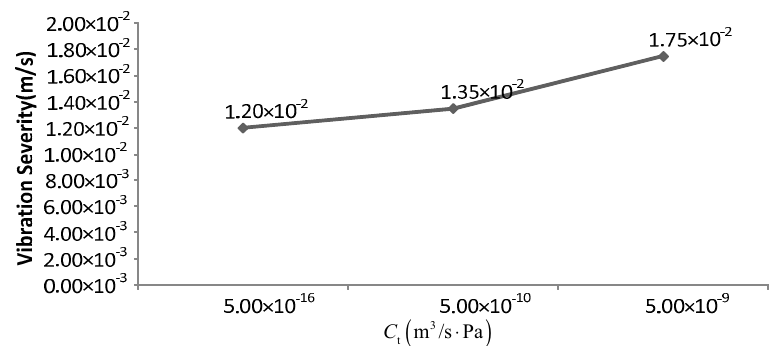
ff ect of leakage coe ffi cient on vibration severity of hydraulic Figure 7. Effect of leakage coefficient on vibration severity of hydraulic cylinder. Figure 7. E